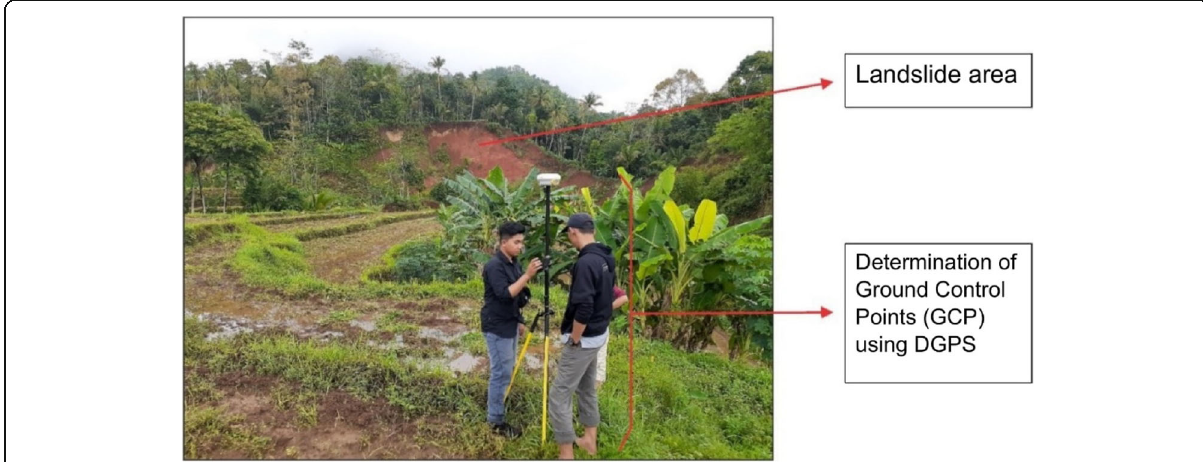
Fig. 2 Measurements of Ground Control Points (GCP) in the research